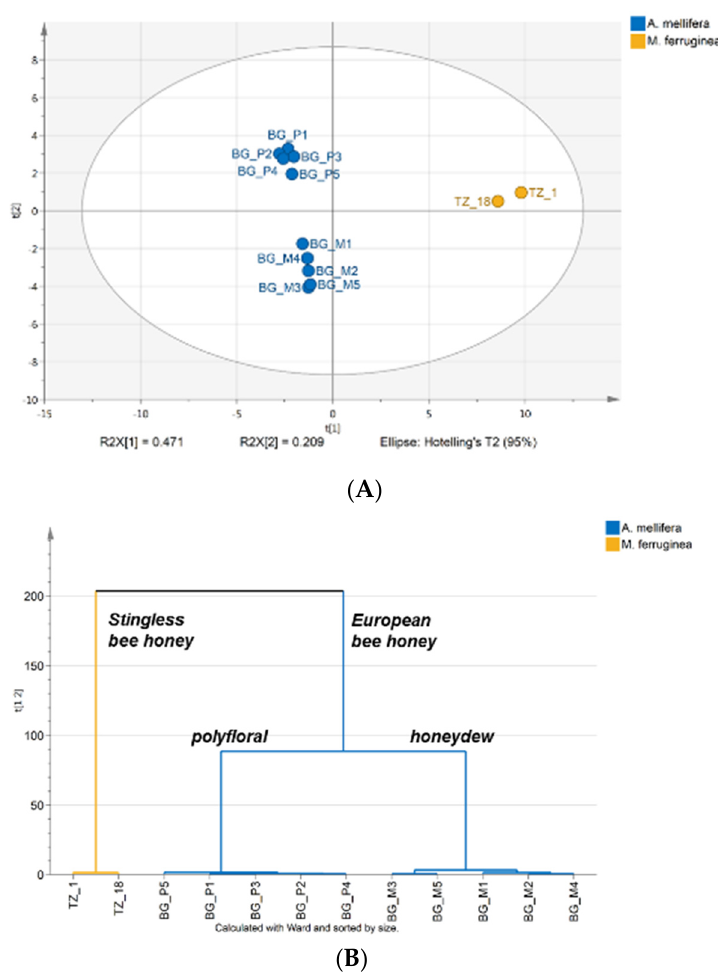
Figure 6. ( A ). Principal component analysis (PCA) score plot of honey samples based on chemical composition. ( B ). Dendrogram of honey samples constructed in chemical composition.